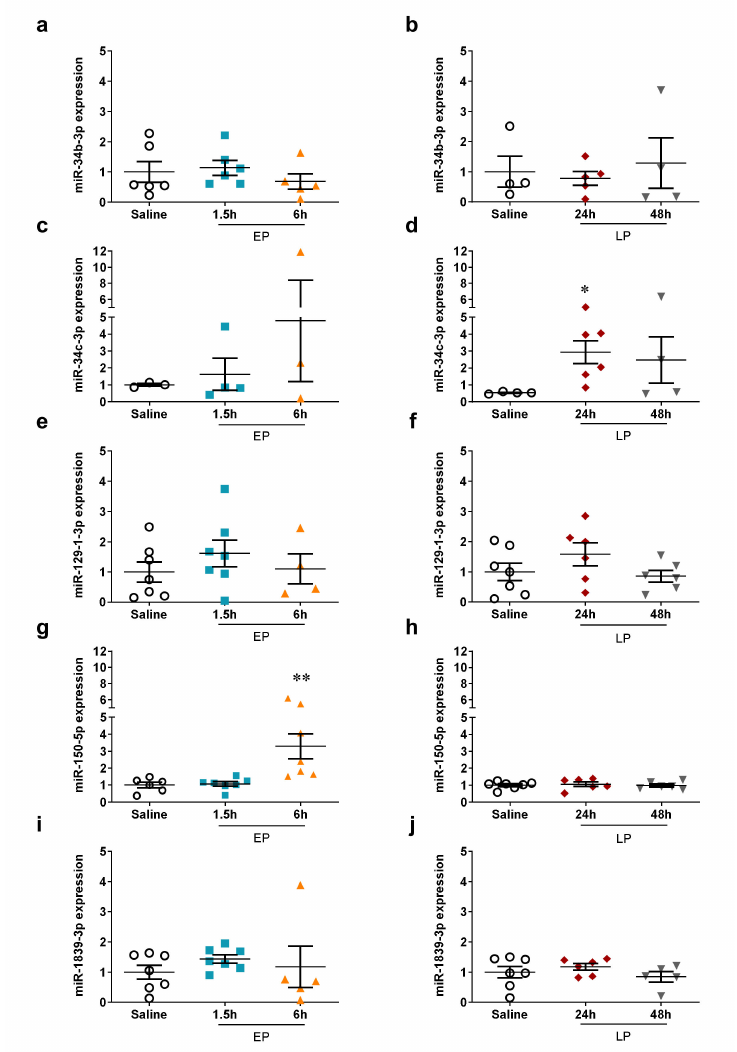
Figure 6. qPCR validation of miRNAs downregulated on the microarray. The relative expression of miRNAs normalized to let-7g-5p (fold changes vs. saline). Left column: EP, right column: LP. ( a , b ) miR-34b-3p; ( c , d ) miR-34c-3p; ( e , f ) miR-129-1-3p; ( g , h ) miR-150-5p; ( i , j ) miR-1839-3p. Data are expressed as mean ± SEM; one-way ANOVA; *: p < 0.05, **: p <